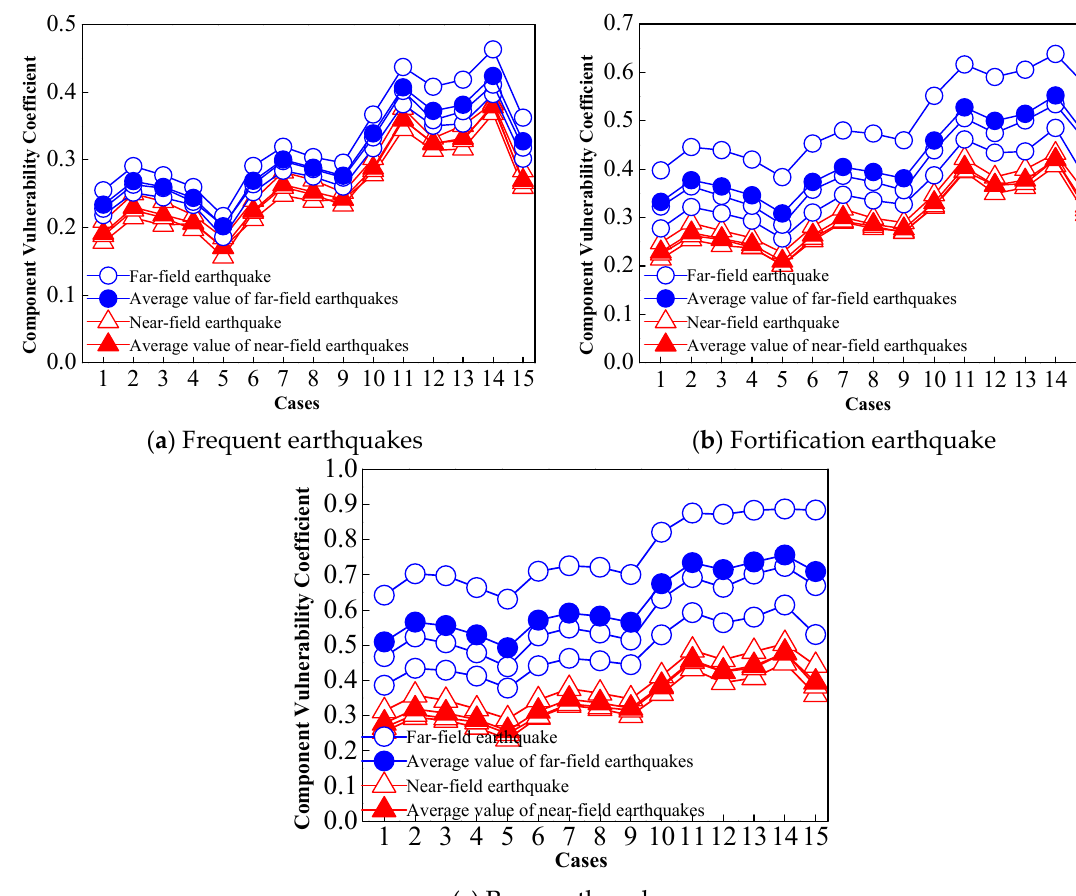
Figure 11. Component vulnerability coefficient curves of model C.